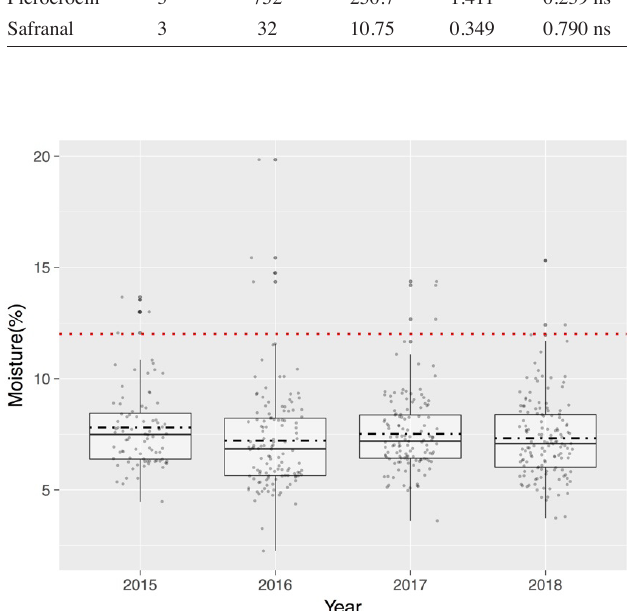
Fig. 5: Boxplots of moisture content in the saffron samples collected/ analyzed during the four years (2015-2018). Red broken line shows the maximum limit (12%) of the three quality categories (ISO 3632 1,2:2010-2011). For each boxplot, mean (black broken line) and median (black line) were highlighted.